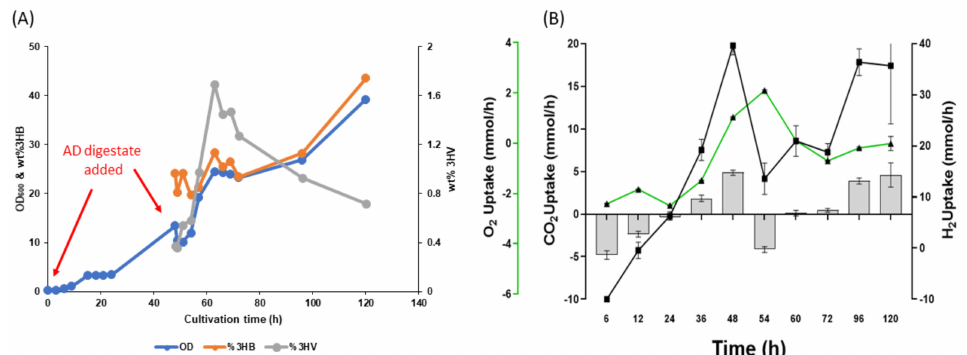
Figure 5. Two-step mixotrophic fermentation using AD derived VFAs, CO 2 and H 2 . Panel ( A ) growth (blue line, OD600), wt% 3HB/CDW (orange line) and wt% 3HV/CDW (grey line) accumulation of C. necator H16 under two-step mixotrophic conditions in a bioreactor, using anaerobic digestate (AD) along with additional CO 2 and H 2 as carbon and energy source. Panel ( B ) gas consumption profile of cultures grown mixotrophically using AD derived VFAs, CO 2 and H 2 . CO 2 and H 2 gas consumption were calculated as average of various time intervals. Legend: CO 2 uptake—grey bars, H 2 uptake—black line and O 2 uptake—green